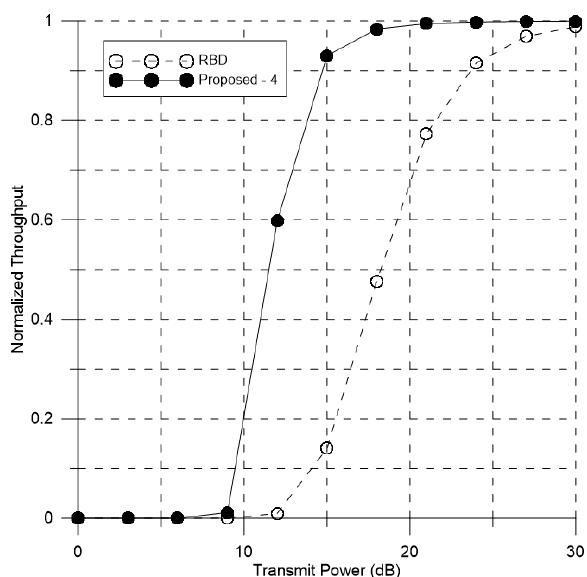
Figure 5. Normalized throughput performance comparison between the RBD and the proposed scheme with N T = N R =